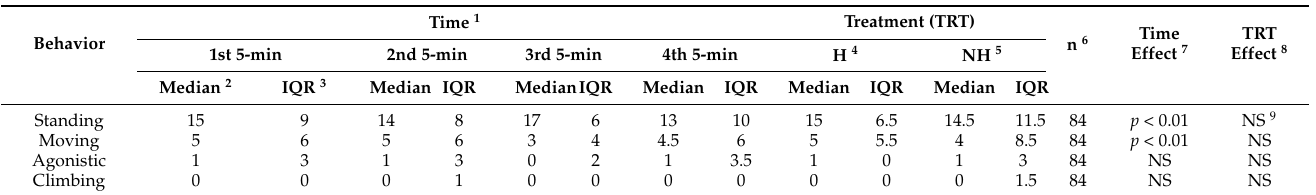
Table 1. Effects of habituation to livestock trailer on the behavior of Spanish goats after loading for